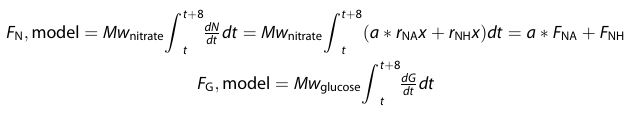
F N ; model : Nitrate demand every 8 h based on model simulation ð mg = L Þ F G ; model : Glucose demand every 8 h based on model simulation ð mg = L